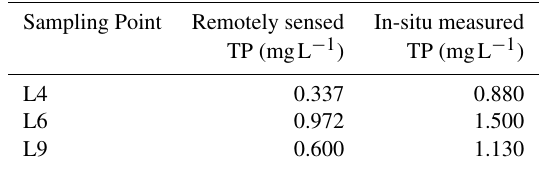
Table 4. Validation of total